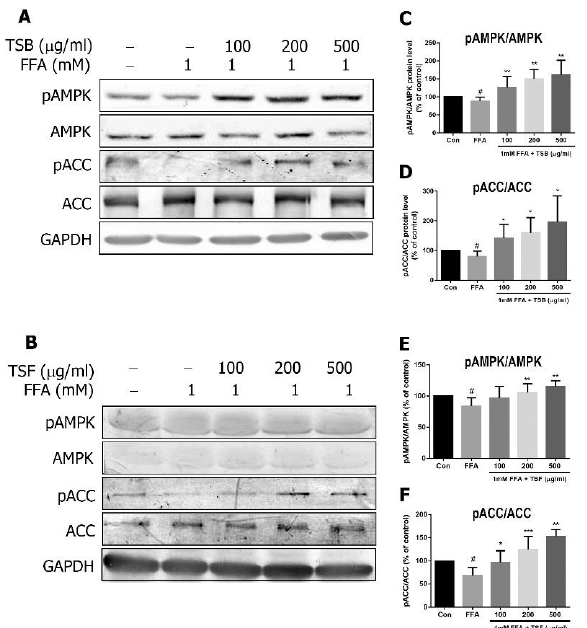
Figure 7. TSB and TSF ’s effects on phosphorylated AMPK and ACC expression in FFA-treated HepG2 cells. ( A and B ) Immunoblots of phosphorylated AMPK and ACC levels. AMPK, ACC and GAPDH were used as internal controls. ( C – F ) The bar graphs show densitometric data (mean ± SD) from three to ten independent experiments. # P < 0.05 compared with the control group (con). * P < 0.05 and ** P < 0.01 compared with the FFA group. *** P < 0.001 compared with the FFA group.